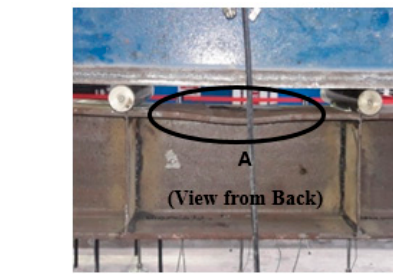
Figure 9. Comparison between test and numerical load–deflection relations of specimens with notch at midspan. Figure 10 shows similar failure modes in tests and FE models (buckling in the com- pression flange). It is apparent from the figure that the predicted numerical failure mode was in agreement with the test failure mode. This similarity between the numerical and test failure modes confirms the accuracy of the numerical simulation generated in this study.